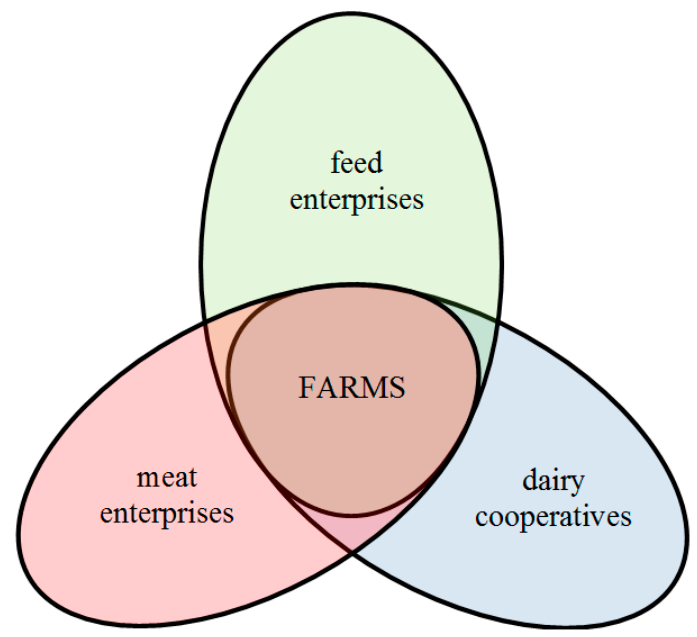
Figure 1. Diagram of relationship between the studied branches.